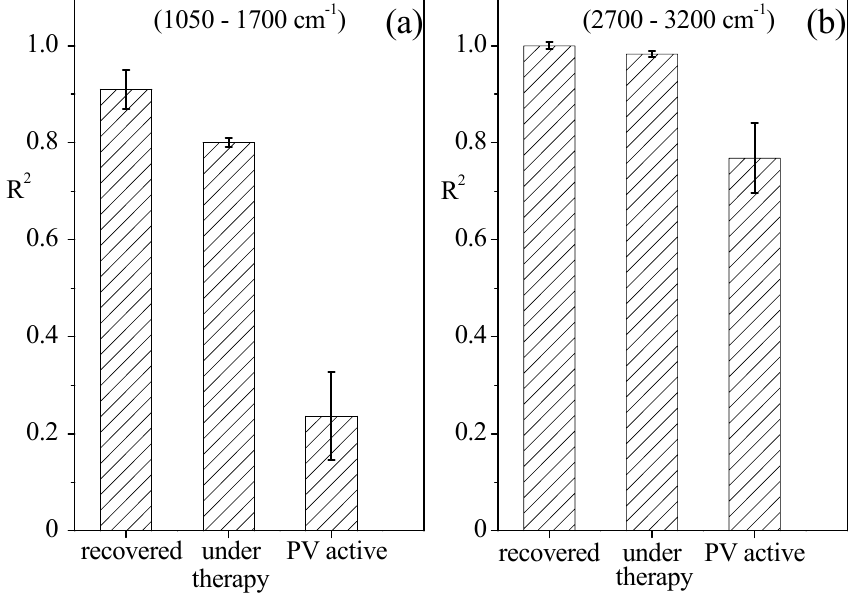
Figure 7. R 2 values (95% confidence level) resulting from linear regression analysis of Raman spectra relative to oral biopsies from (recovered) patients in the remission stage of illness, from patients under drug therapy and from affected PV patients in the wavenumber 1,050–1,700 cm − 1 region (a) and 2,700–3,200 cm − 1 region (b) . Columns indicate the mean of R 2 values. The vertical bars on the top of columns indicate the R 2 variability